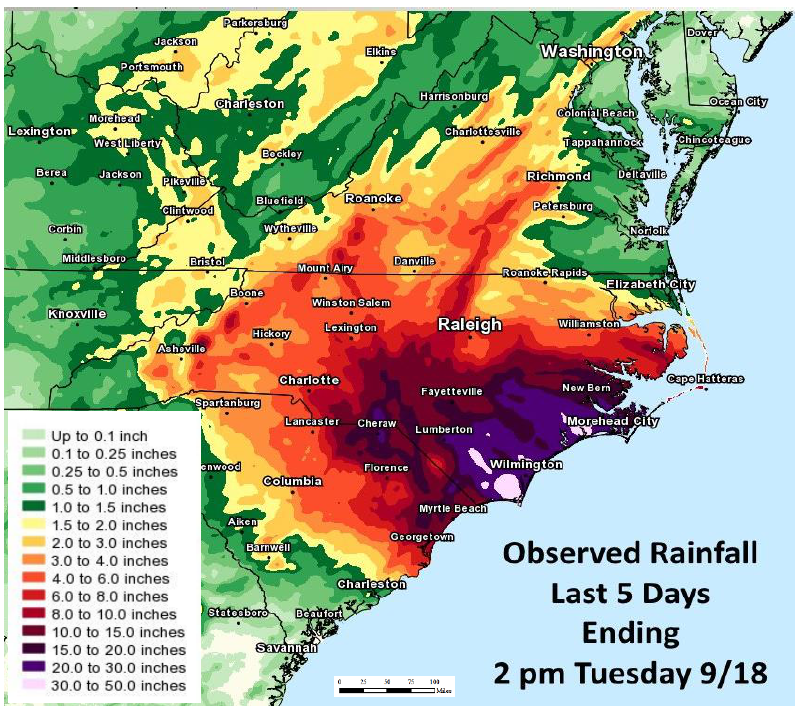
Figure 1. Hurricane Florence Rainfall Map (NWS Eastern Region Headquarters on 18 September 2018).